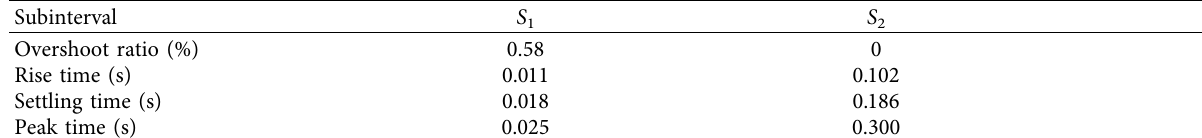
Table 4: Performance specification of the estimated transfer function model.